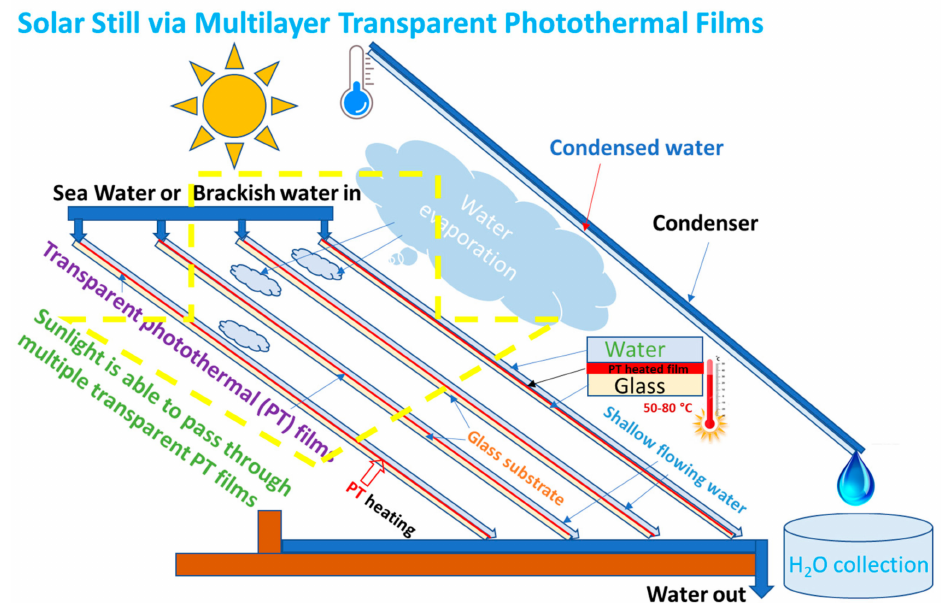
Figure 13. The lab-scale transparent multilayer 3D photothermal solar desalination